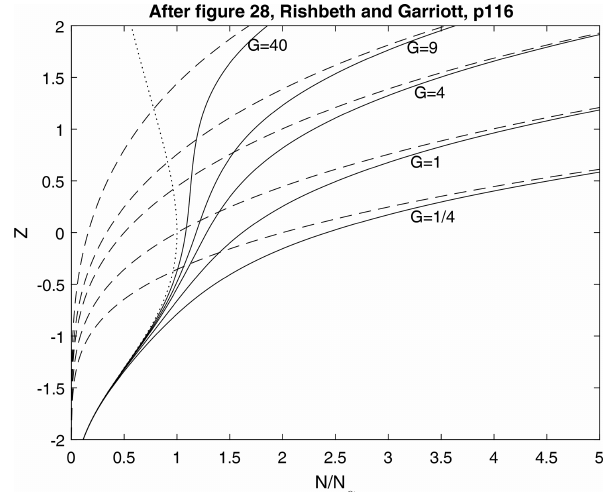
Figure 1. Electron concentration versus reduced height for the iono- spheric transition region. For a Chapman production function, q(z) , with peak at z = 0 and a square-law loss coefficient α . A linear loss coefficient β = β o exp ( − 1 . 75 z) is used, with five values of β o rep- resenting G values of 1 / 4, 1, 4, 9 and 40. The dashed lines rep- resent N β = q/β . The dotted line represents N α = (q/α) 1 / 2 . The solid lines are the profiles N(z) calculated from Eq. (7), scaled by N α 0 = (q o /α) 1 / 2 . The F1 ledge is most pronounced for G = 40 and absent for G = 1 /